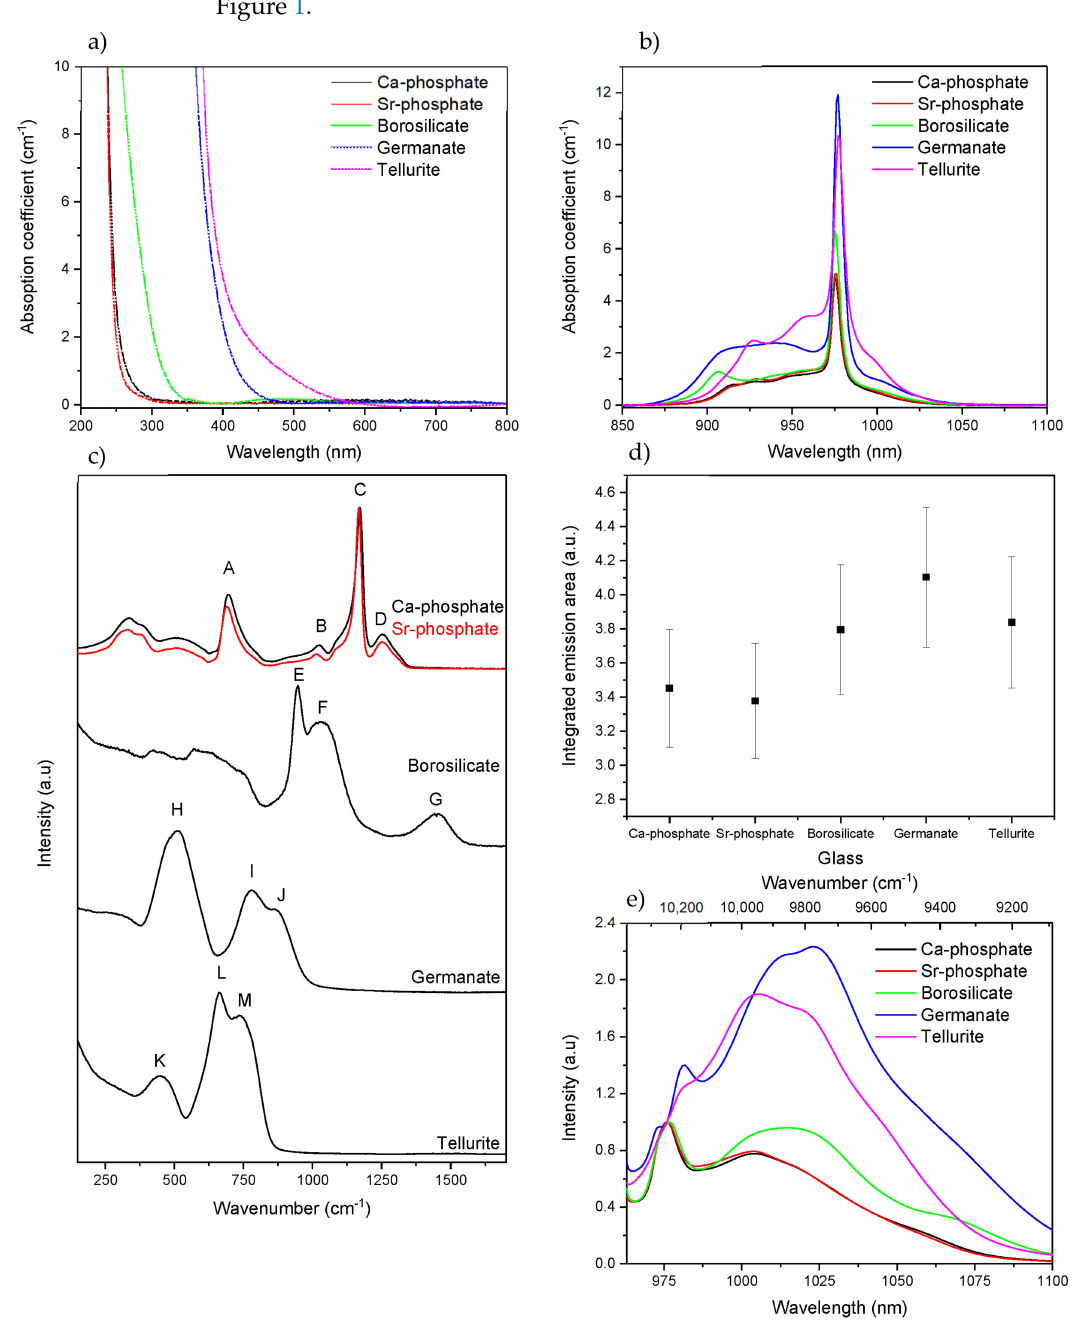
Figure 1. Absorption spectra ( a , b ), Raman spectra [see text for letter attribution] ( c ), integrated emission area ( d ) and normalized emission band of Yb 3+ (normalization on the zero line of the 2 F → 2 F 5/2 7/2 transition, see text) of the bulk glasses prior to irradiation. ( e ) (